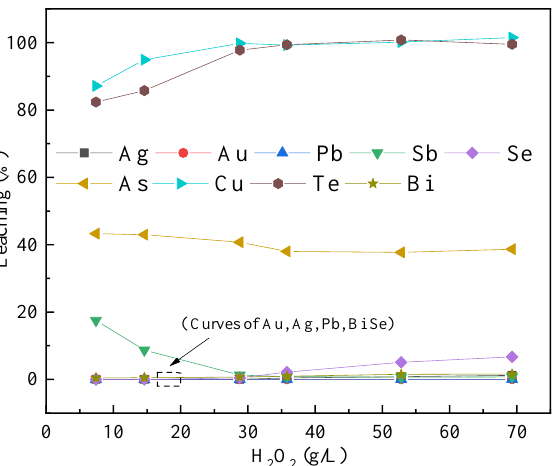
Figure 8. Effect of the hydrogen peroxide concentration on the leaching of each element (t = 2 h, T = 150 °C, P = 0.8 MPa and H 2 SO 4 = 250 g/L). The main element contents of the leach residue are shown in Table 3. The leach residue contained 18.06 wt% Pb, 14.66 wt% Bi, and 9.87% wt% Se, whereas the Ag, Au and